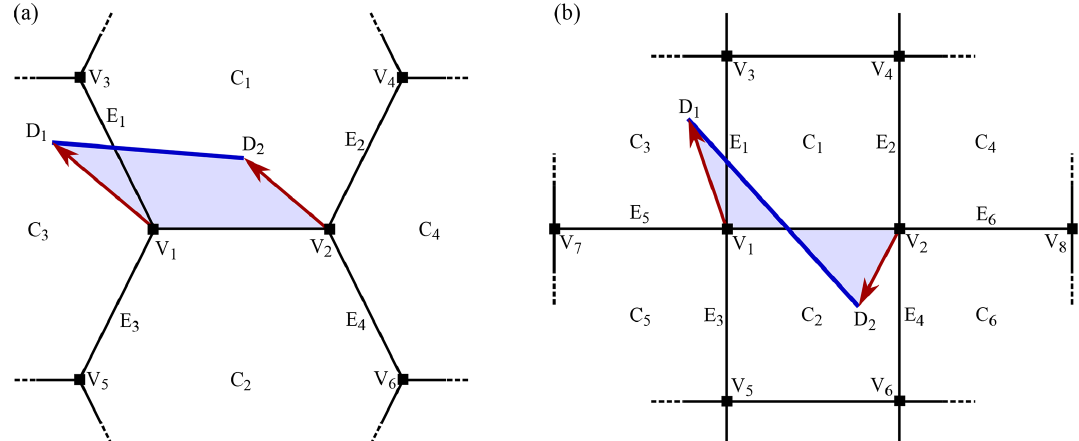
Figure 4. (a) Schematic showing transport across a cell edge on a standard MPAS mesh with three edges meeting at each vertex. The letters C, E, and V denote cell centers, edges, and vertices, respectively. Vertices are also shown with a square marker. Backward trajectories are shown as red arrows, ending in departure points D 1 and D 2 . These backward trajectories define the departure region, which is shaded in blue. (b) Schematic showing transport across a cell edge on a quadrilateral MPAS mesh with four edges meeting at each vertex. Shaded regions are the departure